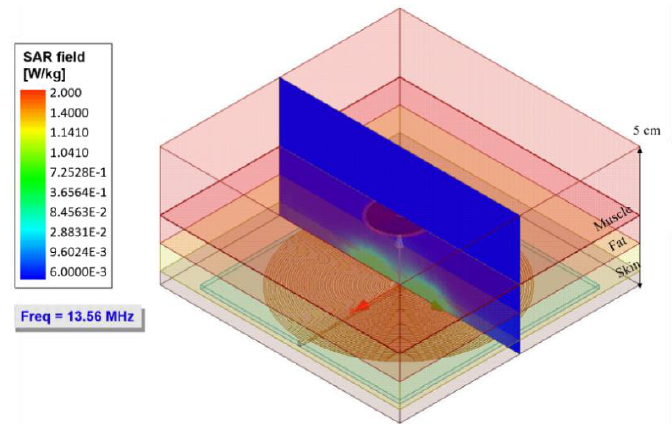
Figure 12. The specific absorption rate for the bidirectional IPT system at the operating frequency of 13.56 MHz.